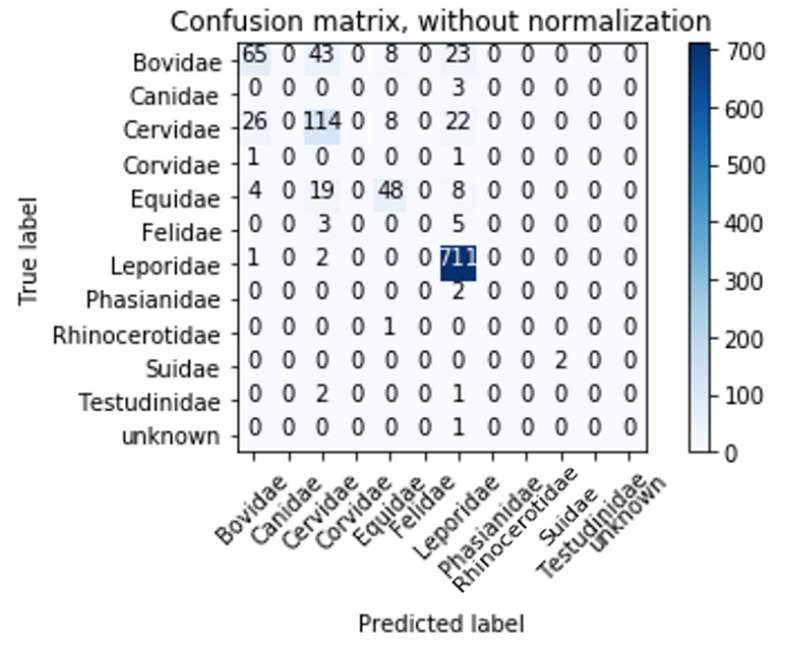
Figure 4. Confusion matrix of the coarse granularity.